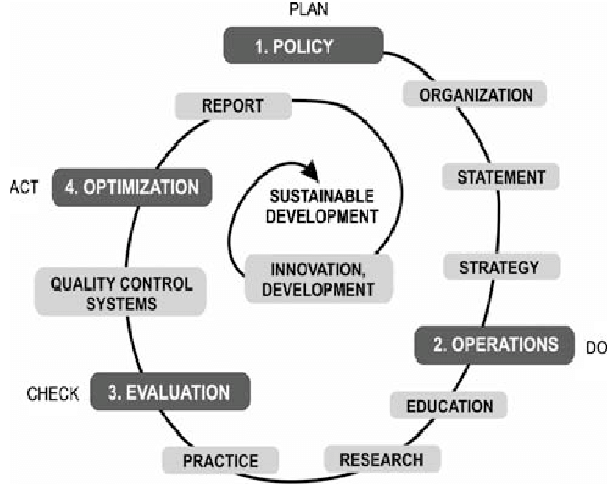
Figure 11. Process and Elements of a Sustainable University. Source: Based on Glaviˇc and Lukman (2007). Source: www.google.com (accessed on 1 December 2022) based on Glaviˇc and Lukman (2007).